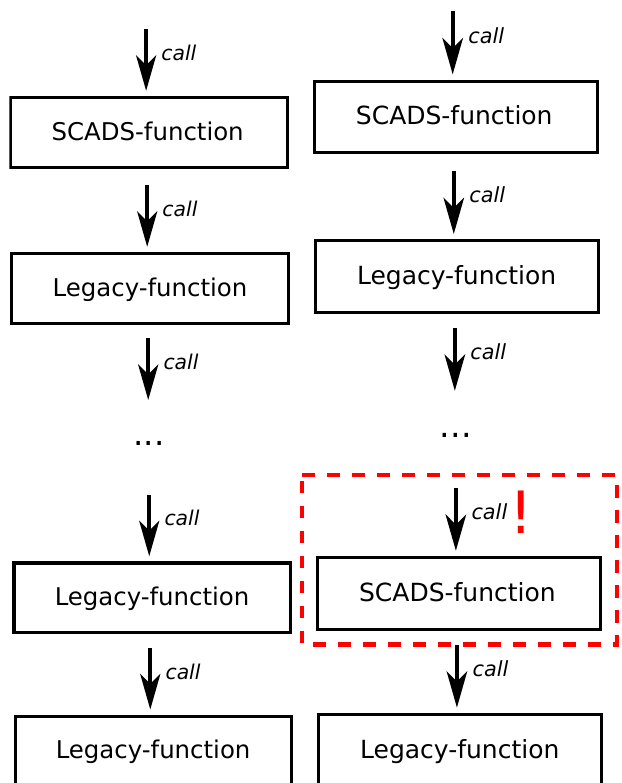
Figure 18. call hierarchy with mixed function